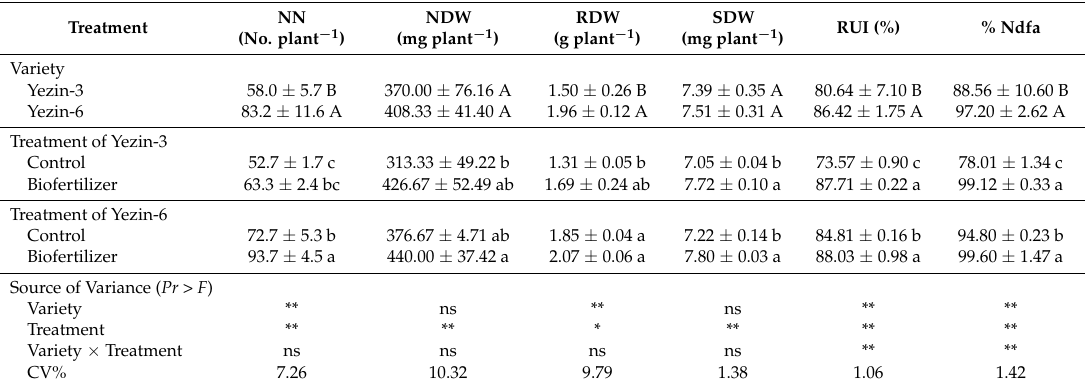
Table 5. Effect of biofertilizer on plant growth, nodulation and nitrogen fixation in terms of RUI (%) and % Ndfa of Yezin-3 and Yezin-6 soybean varieties at R3.5 stage.